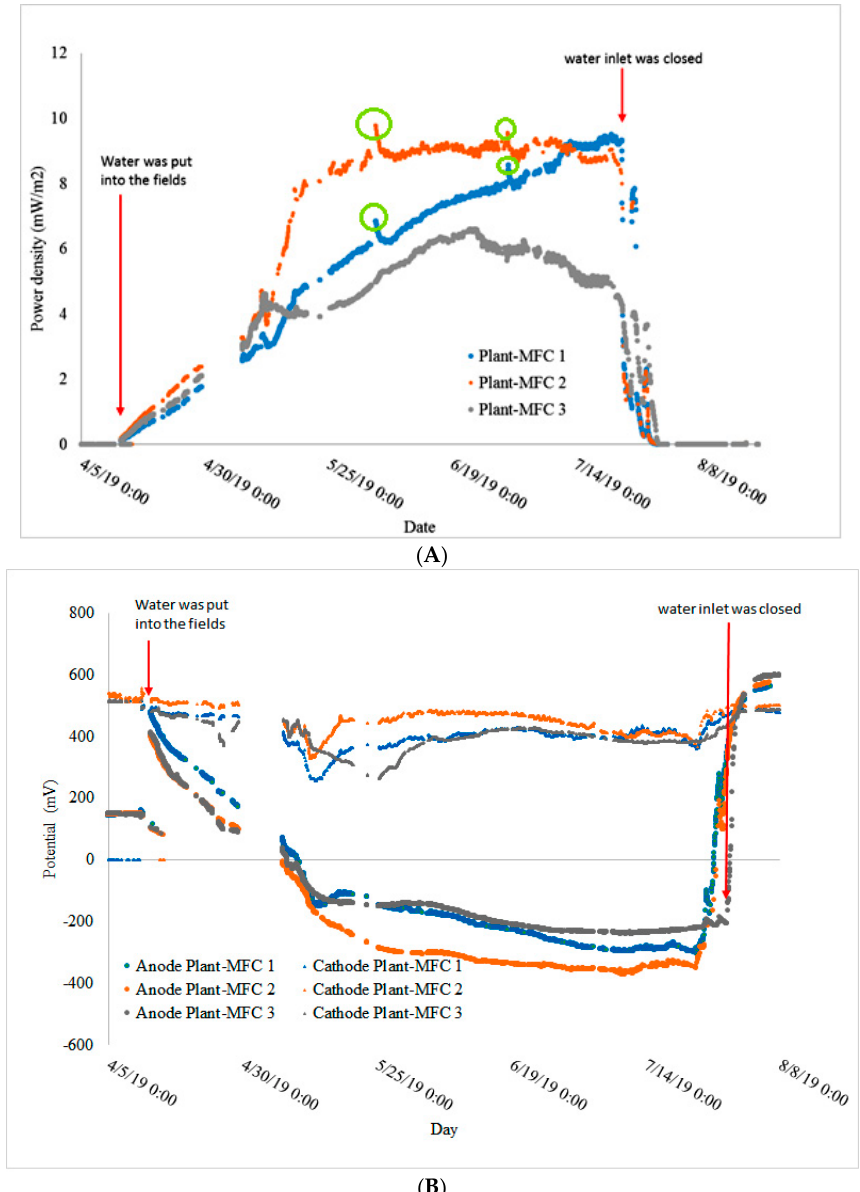
Figure 6. Tubular plant-MFCs performances during fourth crop season: ( A ) power density, and ( B ) anode and cathode potential.